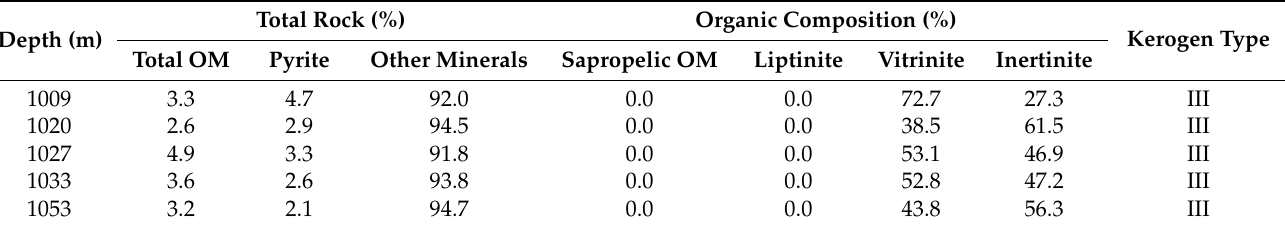
Table 1. Bulk and maceral compositions of source rock samples from well Chaiye 2.